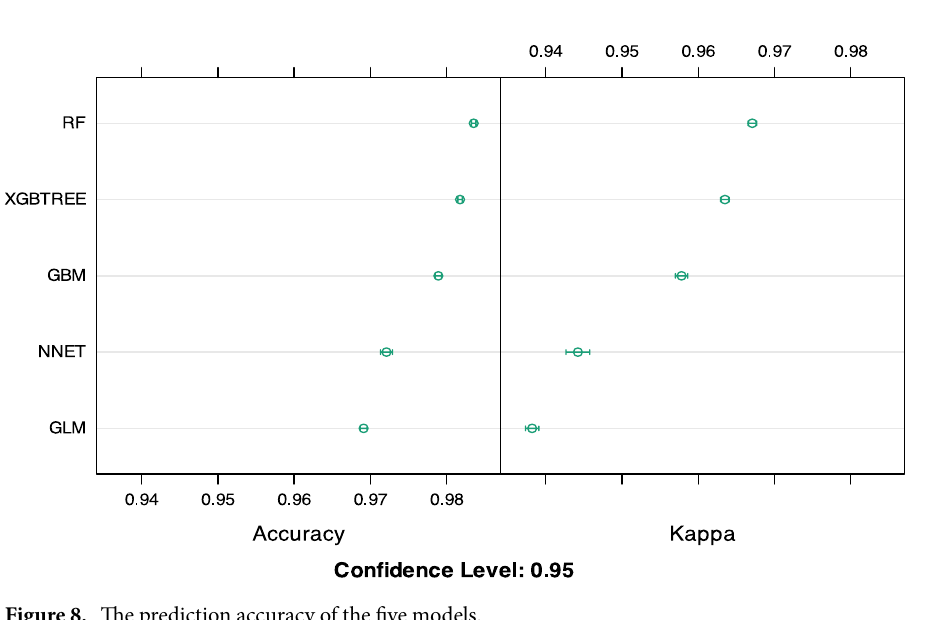
Figure 8. The prediction accuracy of the five